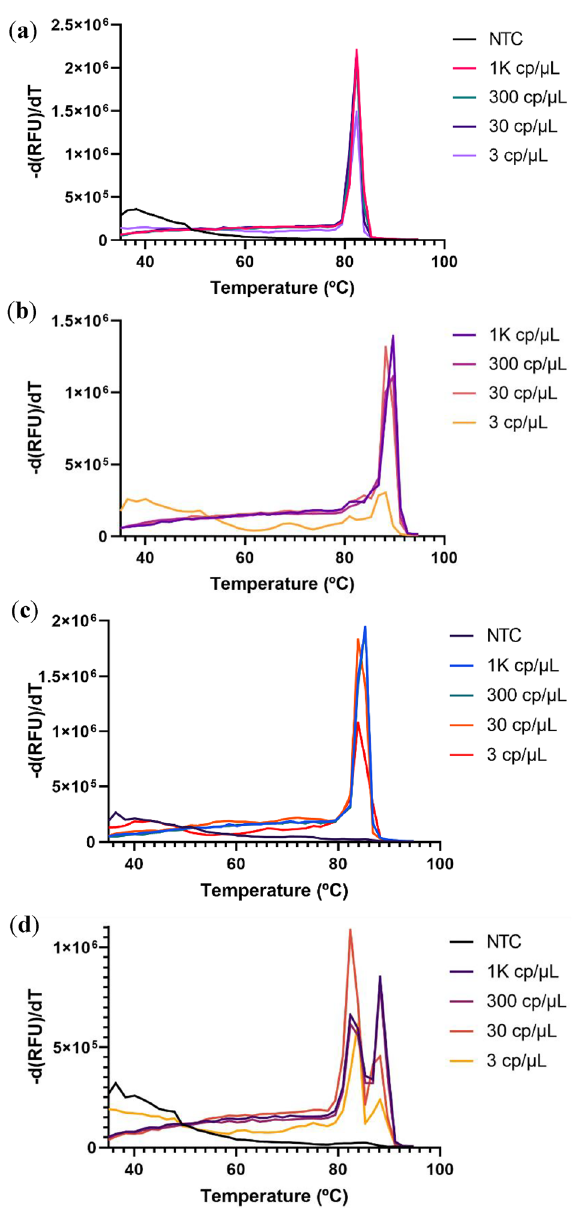
Figure 4. Melting curve analysis of the RT-LAMP reaction. Individual genes were amplified via RT-LAMP using different amounts of synthetic RNA resulting in the corresponding melting curve using E primers ( a ), N primers ( b ), As1 primers ( c ) and multiplex amplification ( d ). This analysis was used to validate the successful amplification in the RT-LAMP reaction using an intercalating dye from 35 to 95 °C with a heating ramp of 0.5 °C